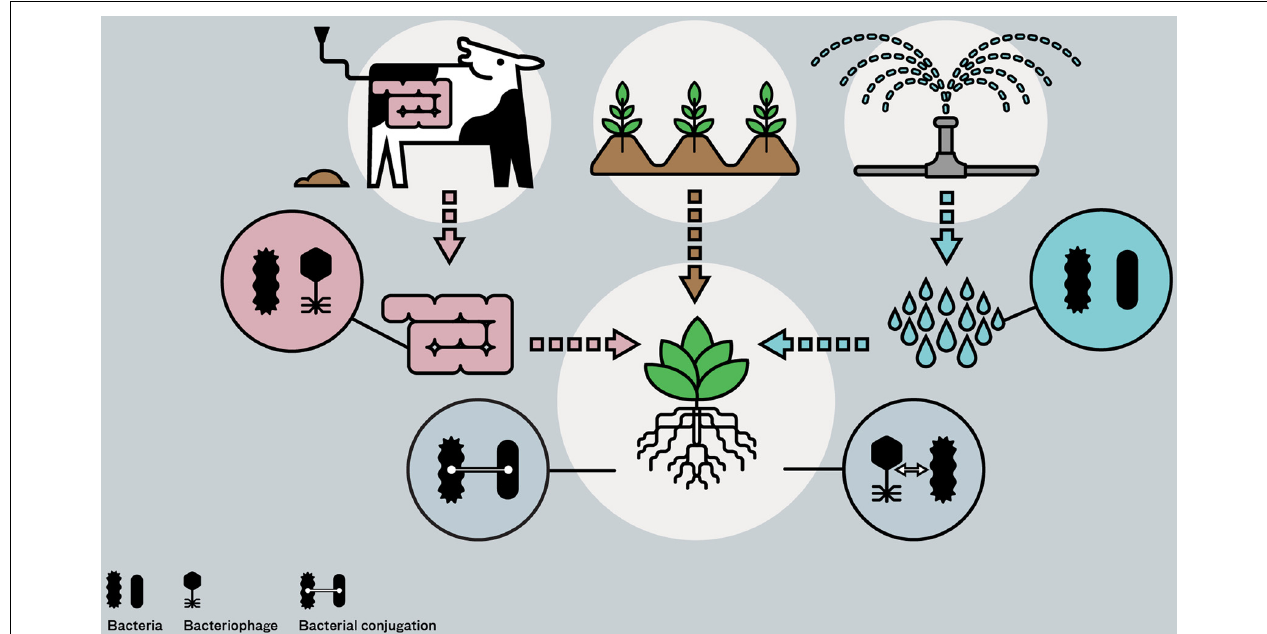
FIGURE 1 | Bacterial communities from different habitats, i.e., from cattle intestinal track system via manure, surface water via irrigation, and from soil and plants, all coming together at plant growth in arable production